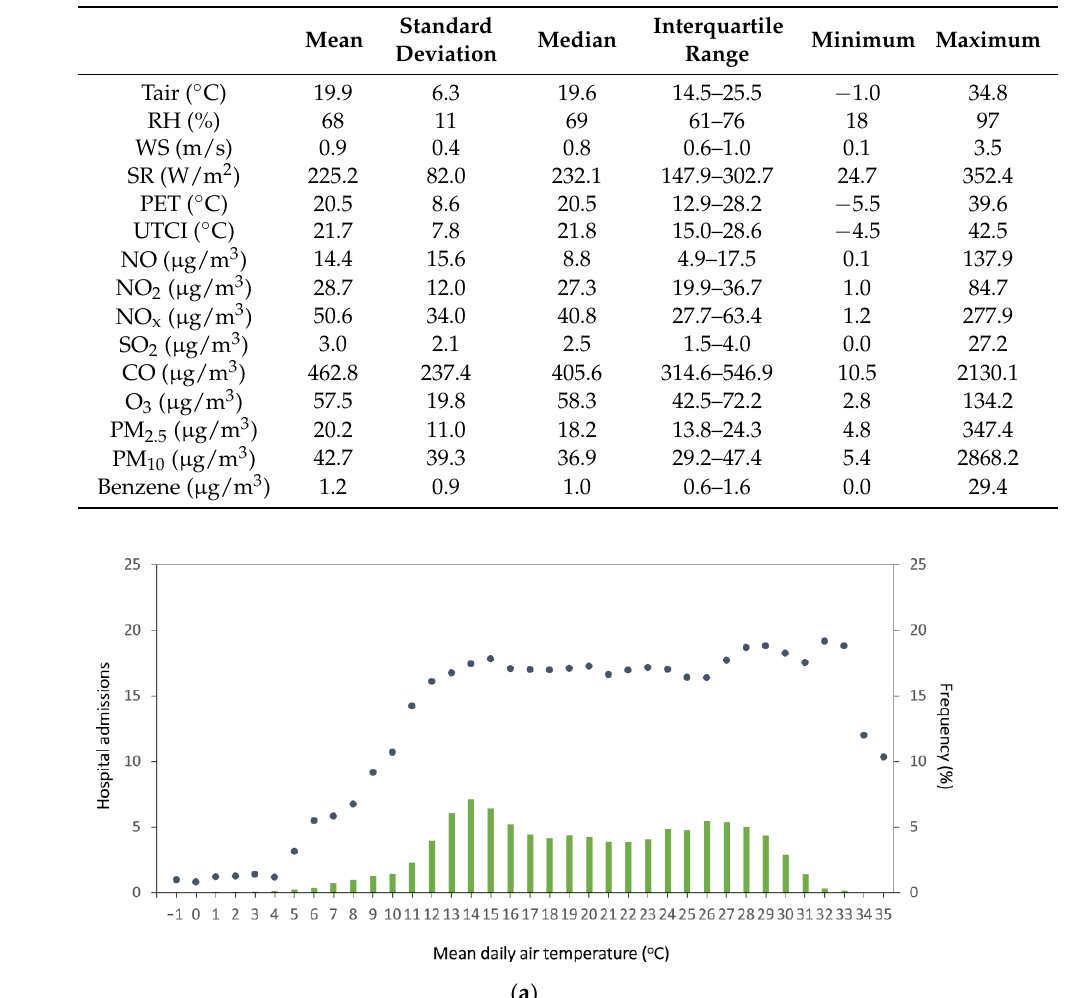
Table 2. Descriptive statistics of the daily means of meteorological variables, thermal indices, and air